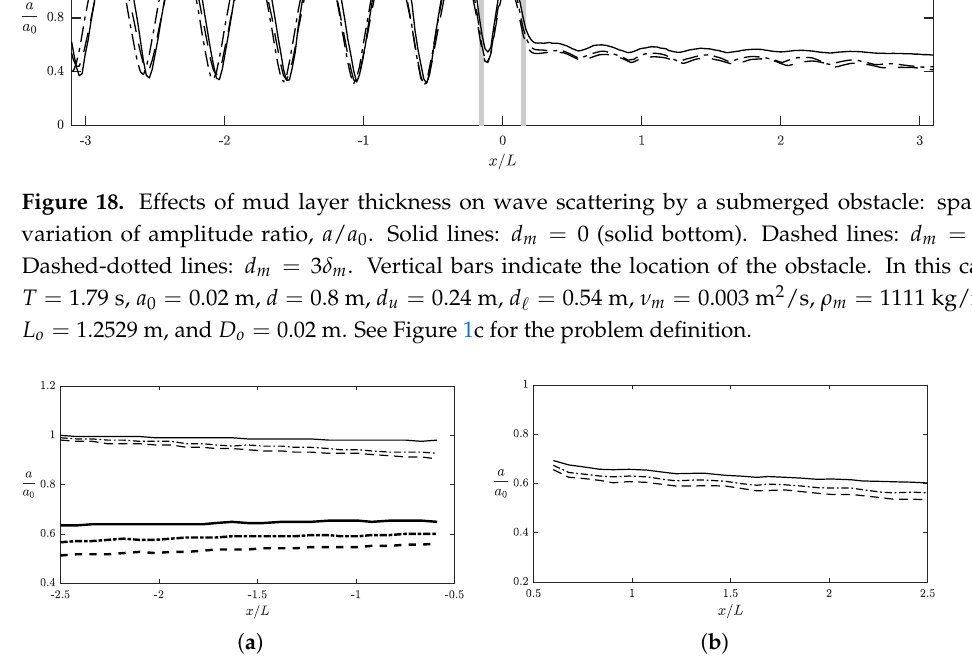
Figure 19. Wave components corresponding to the case of a submerged obstacle shown in Figure 18: ( a ) incident waves (thin lines) and reflected components (thick lines); ( b ) transmitted waves. Solid lines: d m = 0 (solid bottom). Dashed lines: d m = δ m . Dashed-dotted lines: d m = 3 δ m . Vertical bars indicate the location of the obstacle. See Figure 18 for the model